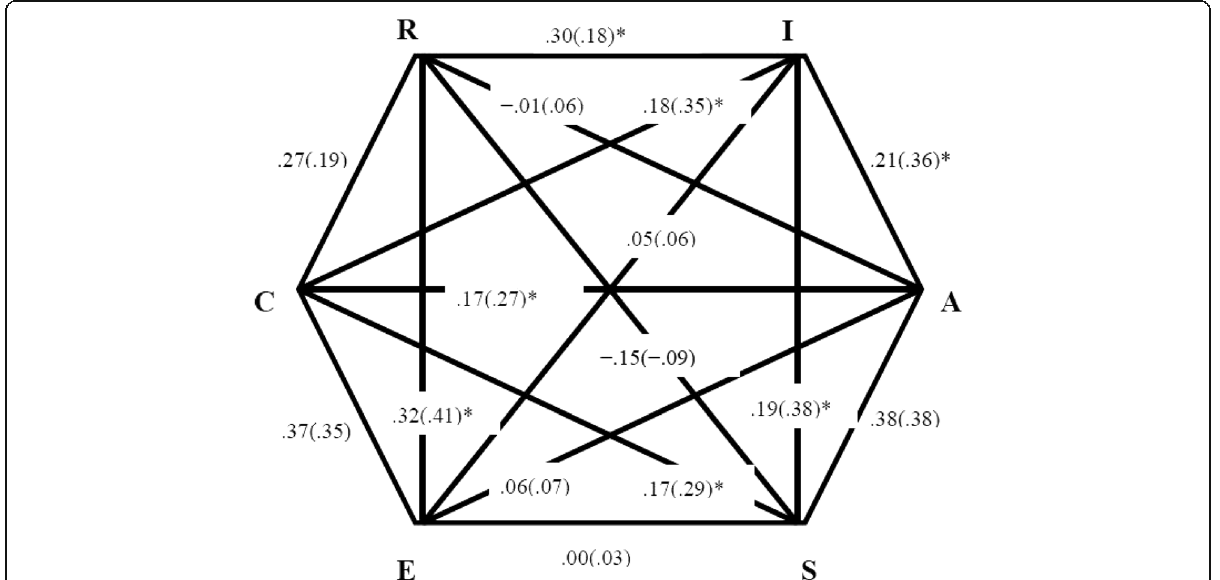
Fig. 2 The observed circular order for the 18-item and the 54-item (inside parentheses) instruments